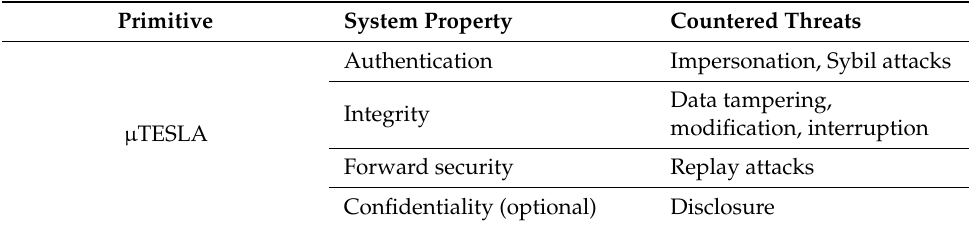
Table 2. Protection aspects of the SPD-Safe’s network layer